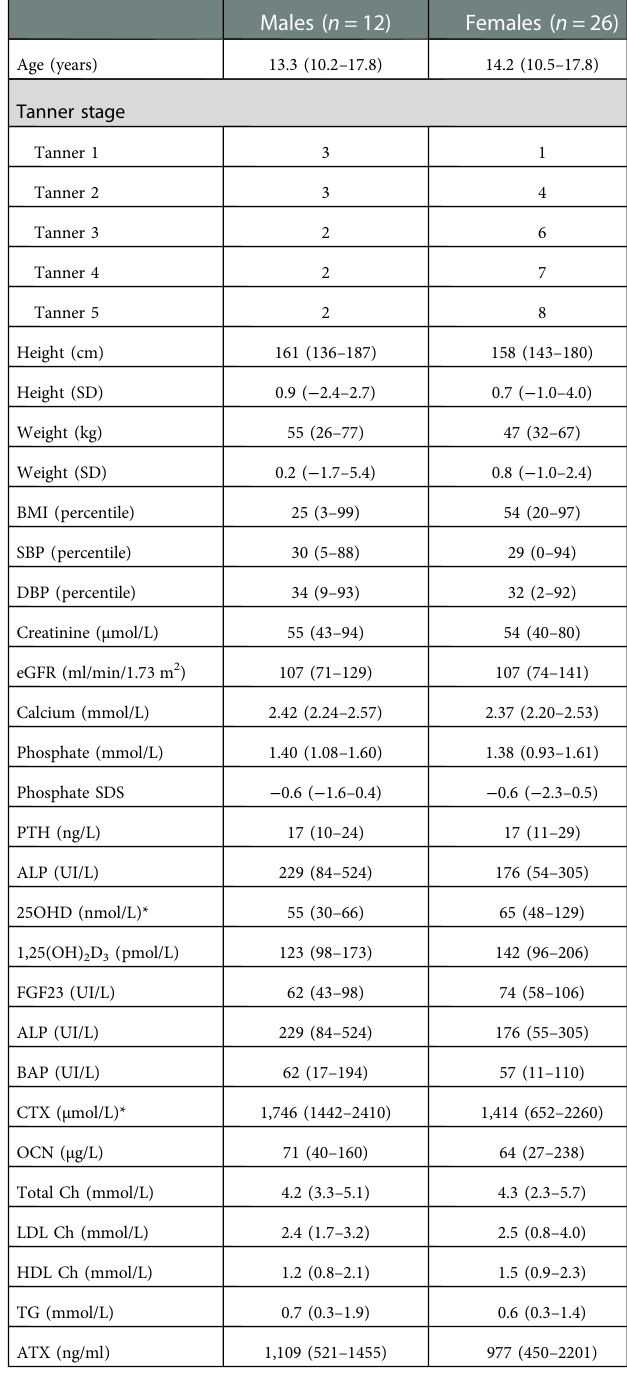
TABLE 1 Demographic and biochemical characteristics of the subjects used for the secondary analysis of the VITADOS